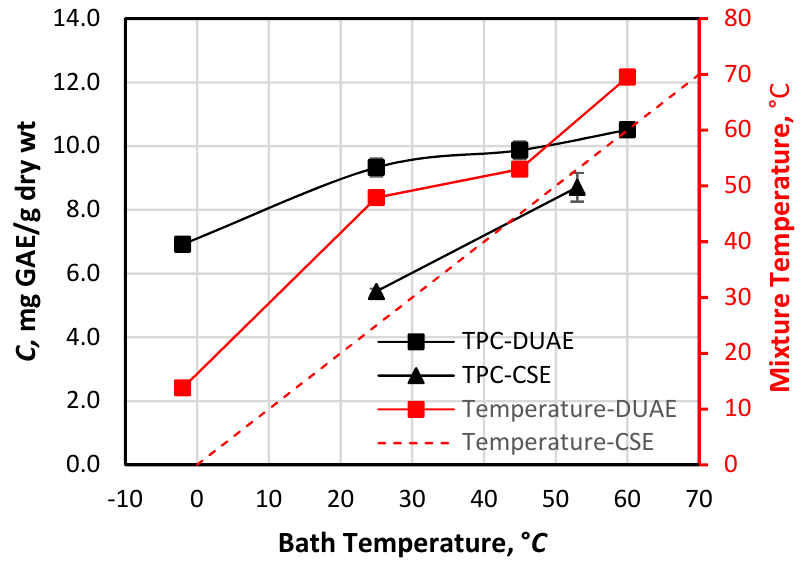
Figure 6. Relationship between C and bath temperature during DUAE and CSE under the conditions of: solvent-to-solid ratio 40:1; particle size 45–100 mesh (0.150–0.354 mm); and extraction time 30 min. DUAE was operated at 120 W with a frequency of 22.95 kHz.